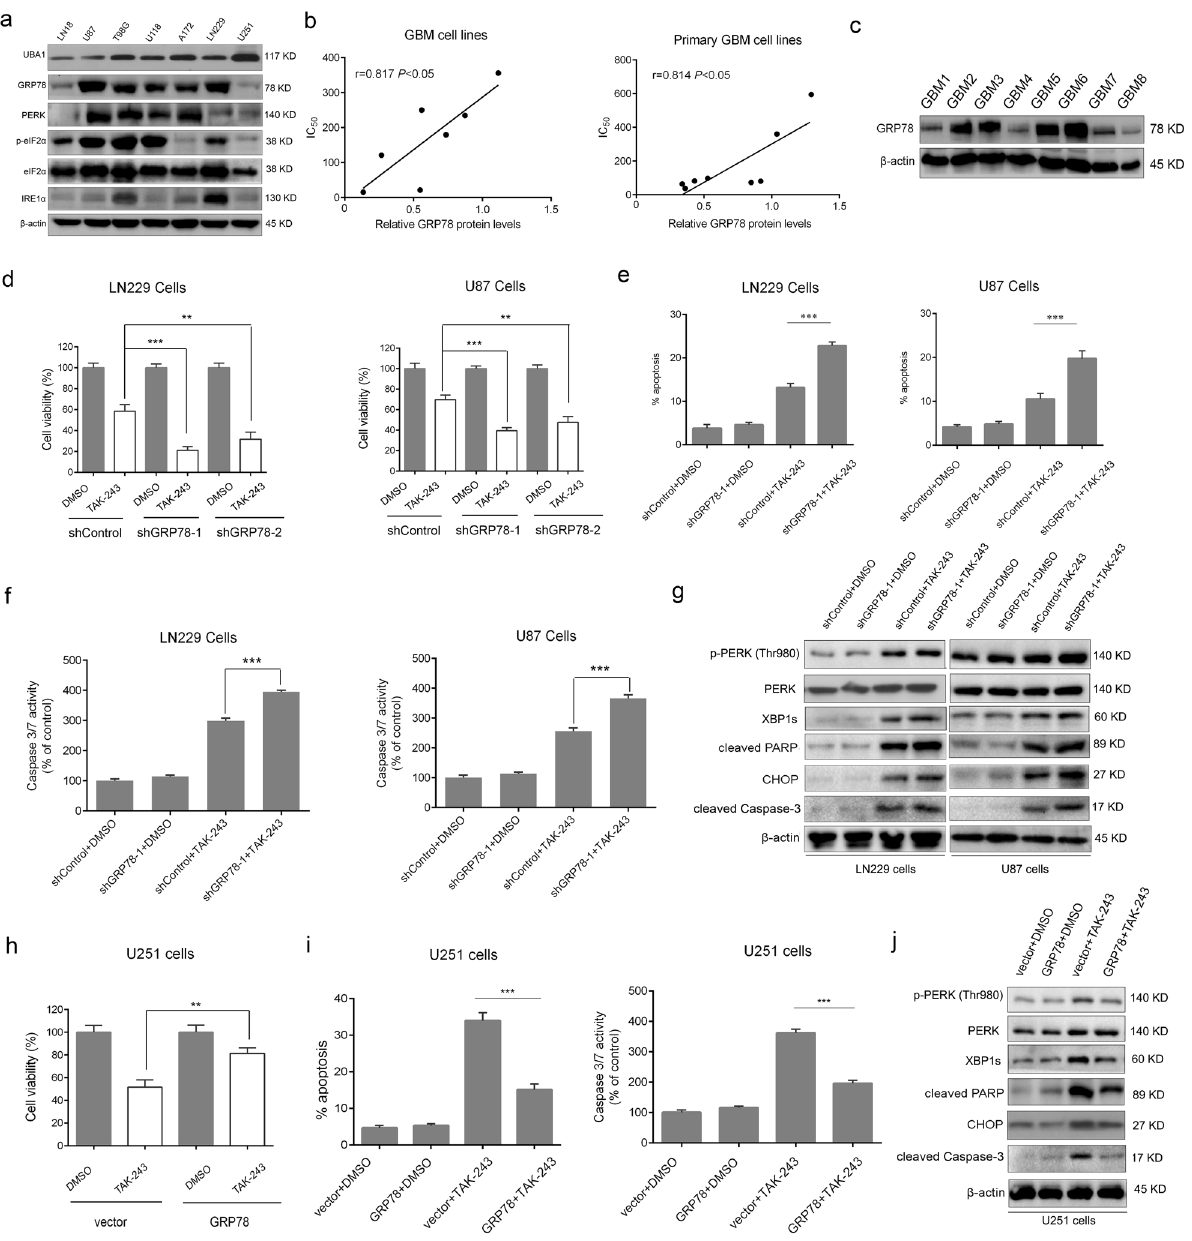
Fig. 5 GPR78 determines sensitivity to TAK-243 in GBM cells. a The expression levels of UBA1, GRP78, PERK, p-eIF2 α , eIF2 α , and IRE1a were evaluated by western blotting in GBM cell lines. b Correlation analysis of relative GRP78 levels and IC50 values of TAK-243 in GBM and primary GBM cells. c The expression levels of GRP78 in eight primary GBM cell lines. d − f LN229 and U87 cells expressed with shGRP78-1 were treated with TAK-243 for 24 h. Cell viability, apoptosis, and caspase 3/7 activity were assessed by CCK-8, Annexin V staining, and Caspase-Glo 3/7 activity assay. g The protein levels of p-PERK, PERK, XBP1s, CHOP, cleaved PARP, and cleaved caspase-3 were assessed by immunoblotting in indicated cells. h − i GRP78 overexpressed U251 cells were treated with TAK-243 for 24 h, and then cell viability, apoptosis, and caspase 3/7 activity were assessed. j The expression levels of p-PERK, PERK, XBP1s, CHOP, cleaved PARP, and cleaved caspase-3 were assessed by immunoblotting in indicated cells. All the Data are presented as means ± SD. ** P < 0.01, *** P < suppresses tumor growth in preclinical models. We constructed cytometry analyses using Annexin V and PI as apoptosis markers a nude mouse subcutaneous GBM tumor model with LN229 (Fig. 6j and Supplementary Figs. S7, S8). Taken together, the cells and analyzed the size and weight of xenograft tumors. higher sensitivity of GSCs to TAK-243 indicates that targeting The results showed that TAK-243 treatment signi fi cantly UBA1 may be a promising approach for eliminating GSCs. inhibited the growth of subcutaneous tumor cells in nude mice. The tumor volume of the treatment group mice was TAK-243 inhibits tumor growth and prolongs the survival of signi fi cantly smaller than that of the control group, and the tumor-bearing mice in a PDX mouse model tumor weight also gradually decreased with increasing drug To determine the clinical application of this drug, we examined dose (Fig. 7a – c). whether pharmacologic inhibition of UBA1 by TAK-243